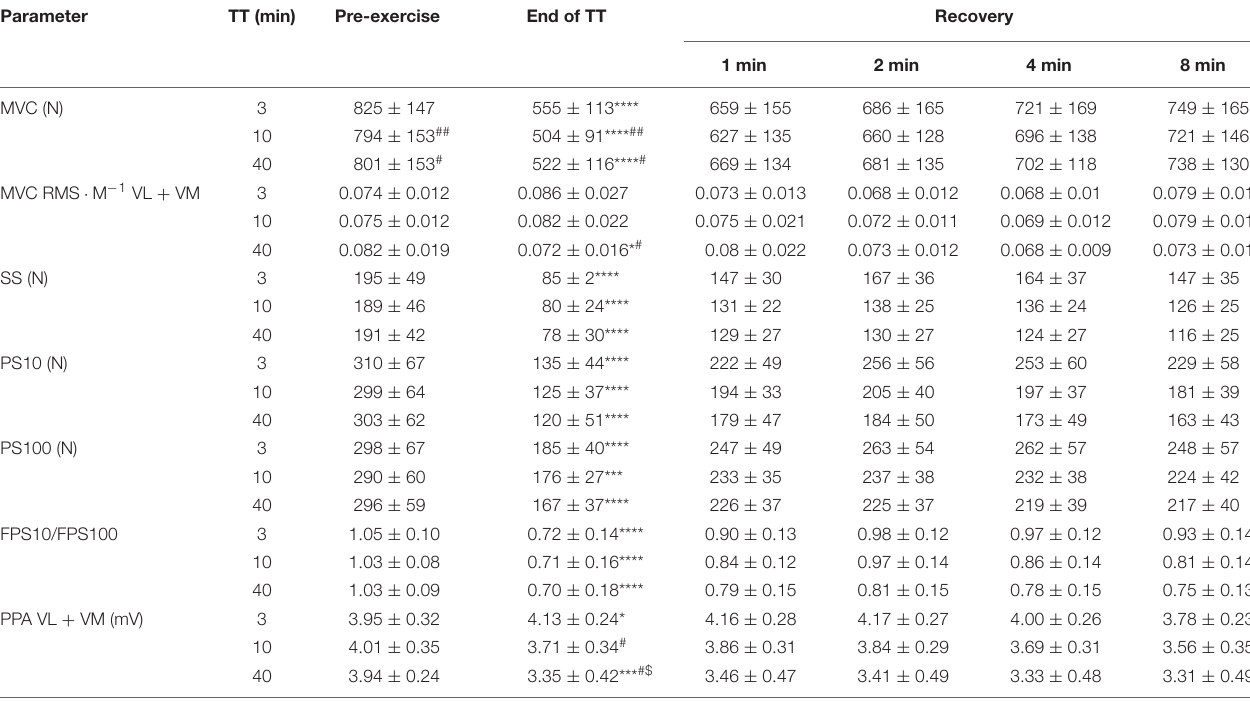
TABLE 1 | Neuromuscular function for each distance at pre-exercise; at the end of TT; and after 1, 2, 4, and 8 min of recovery. Parameter TT (min) Pre-exercise End of TT Recovery